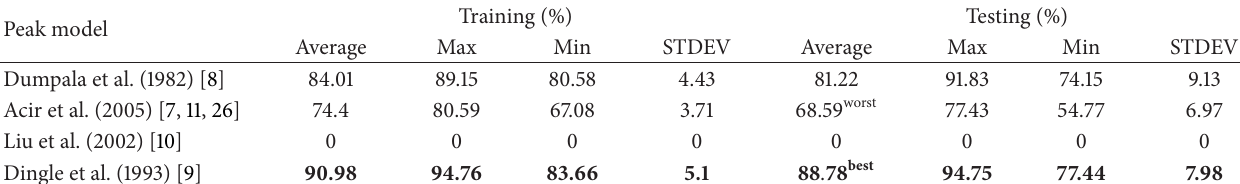
Table 7: Training and testing performance of peak detection for each peak model (without feature selection).